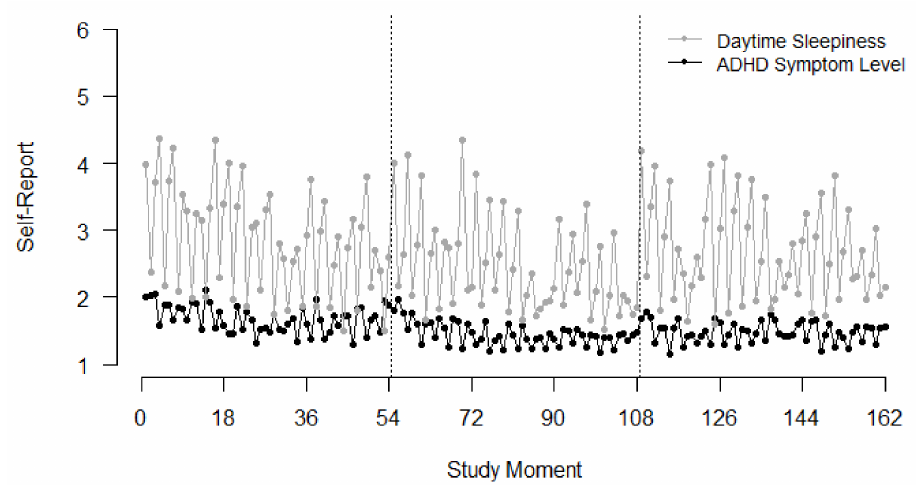
Figure 3. Time course of self-reported daytime sleepiness and ADHD symptom levels across all 162 study moments, with three moments per day; The dashed lines indicate breaks between each